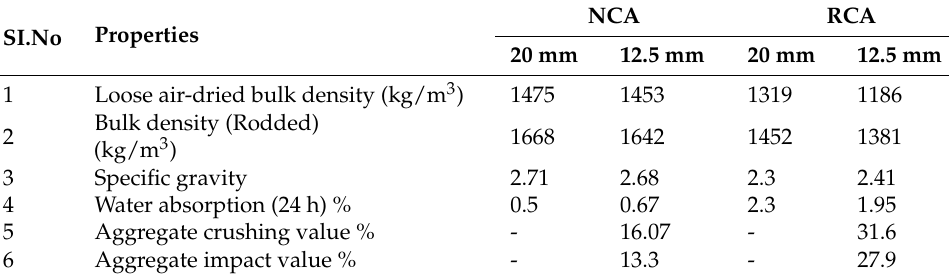
Table 1. Physical and mechanical properties of the aggregates.